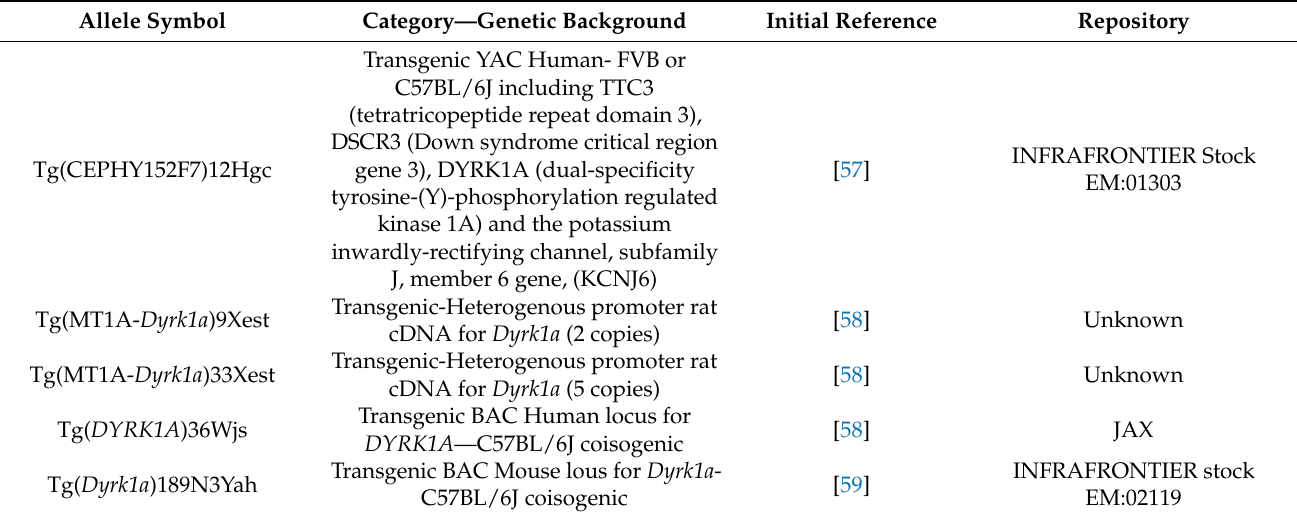
Table 1. Transgenic line overexpressing Dyrk1a in the mouse. Category—Genetic